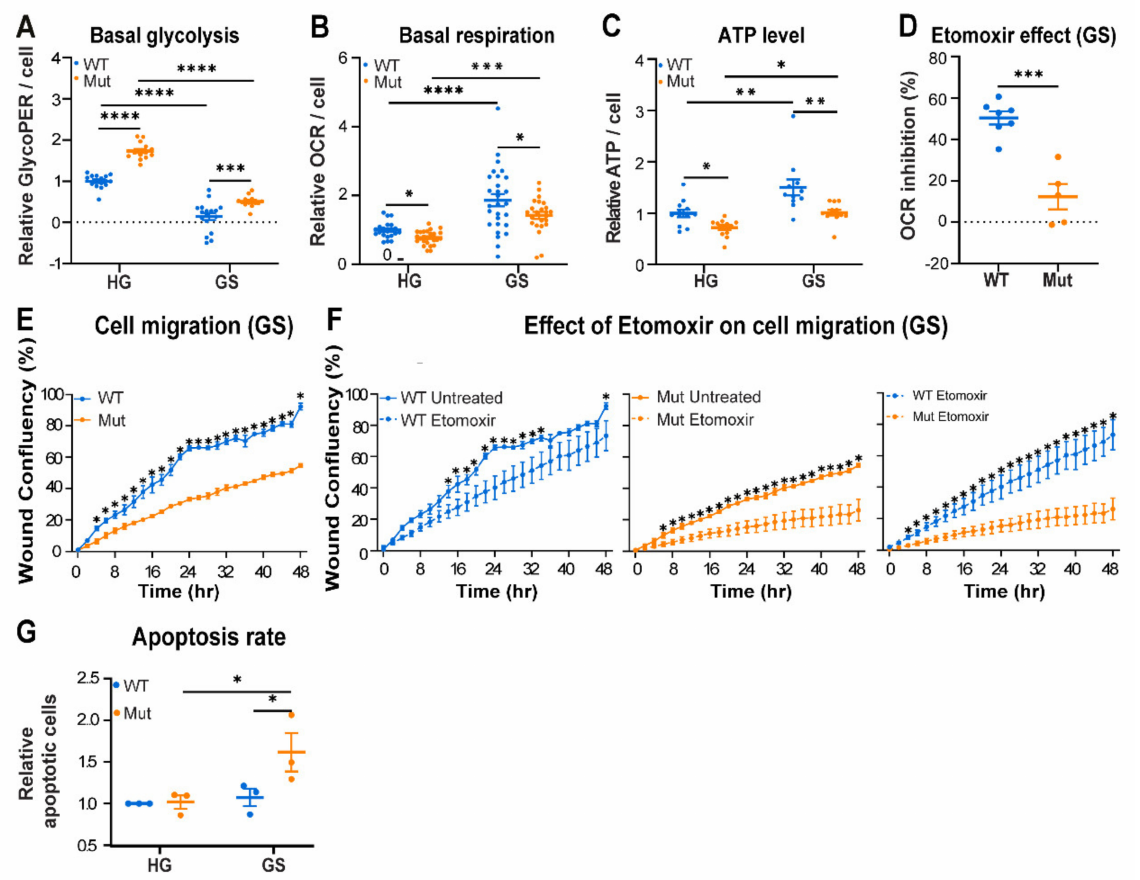
Figure 3. Impact of glucose starvation (GS) on energy status and function of WT (blue) and Mut (orange) primary astrocytes. Cells were incubated for 48 h in DMEM-HG or DMEM-GS medium followed by analyses of: ( A ) Basal glycolysis. Data represent glycolytic proton efflux rate (GlycoPER) per cell. ( B ) Basal respiration. Data represent OCR per cell. ( C ) ATP level per cell. Values in ABC are relative to the mean value of WT-HG. ( D ) Astrocytes grown in DMEM-GS for 48 h were pre-treated or not with 4 µ M Etomoxir for 15 min and analyzed for basal respiration using ‘seahorse medium’ supplemented with 10% FBS as fatty acids source, with or without 4 µ M Etomoxir, respectively. Data show % OCR inhibition by Etomoxir. ( E , F ) Cell migration by wound-scratch assay along 48 h of incubation in DMEM-GS using IncuCyte ZOOM™ apparatus, in the presence or absence of 4 µ M Etomoxir. Shown is average of % wound confluency recorded at 2 h intervals. ( G ) Cell death assessed by staining with FITC-conjugated Annexin-V antibodies followed by analysis by flow cytometry. Data represent average ± SEM of fold change Annexin-V positive cells relative to WT HG. Statistical analysis is detailed in Materials and Methods. All graphs show the average values ± SEM. * p ≤ 0.05, ** p ≤ 0.01, *** p ≤ 0.001, **** p ≤